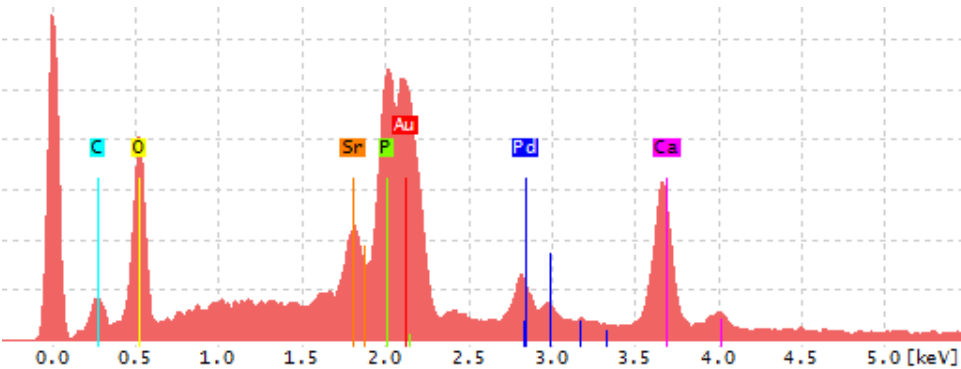
Figure A1. The characteristic energy dispersive X-ray analysis spectra showing peaks corresponding to the elements in the 5-Sr-CaP scaffold.